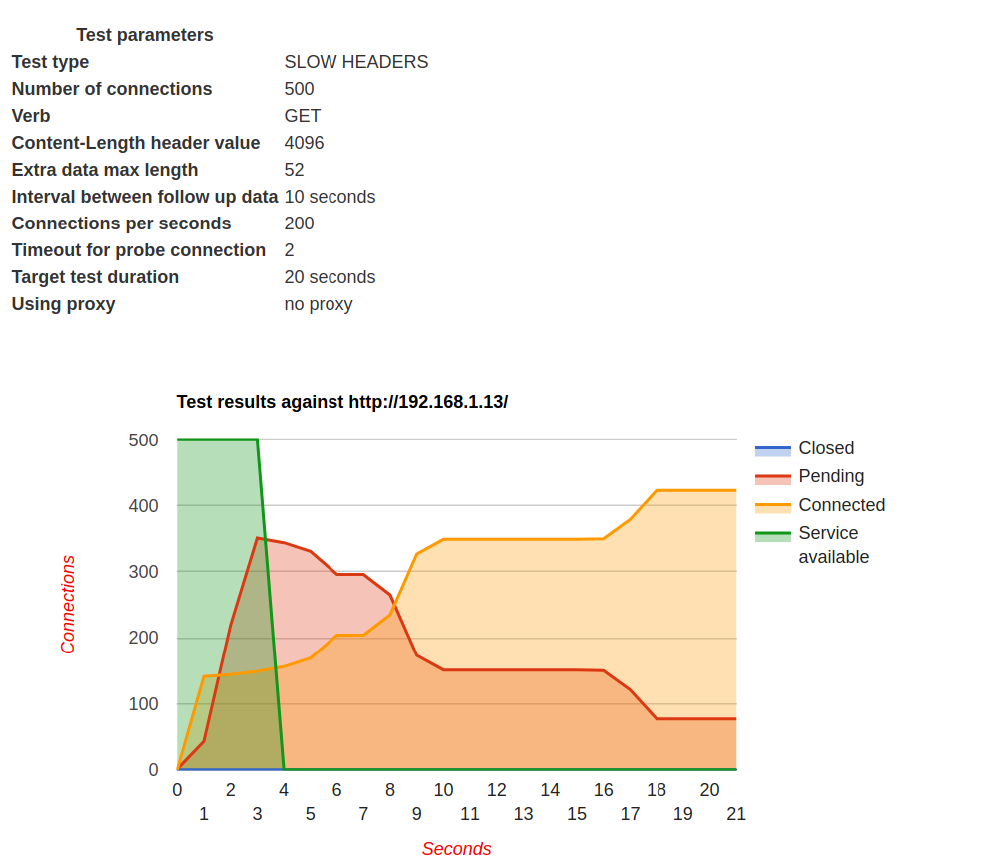
Figure 13. SlowLoris unprotected.